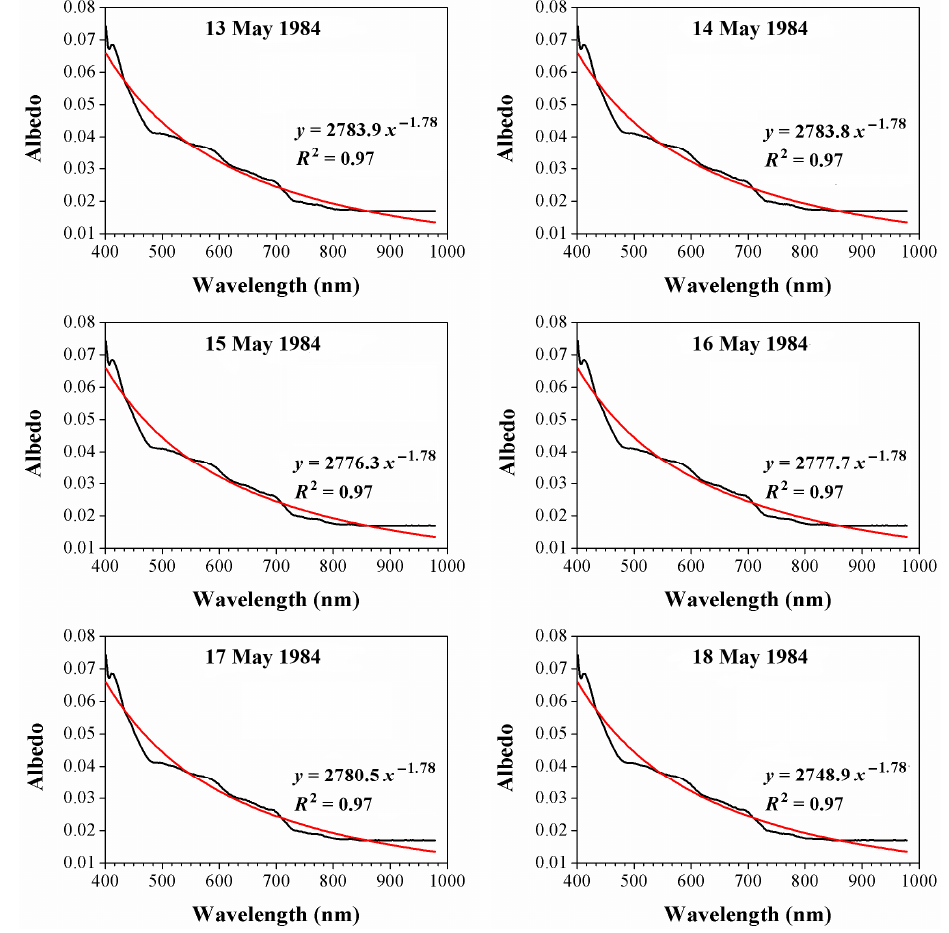
Figure 3. Spectral dependence of water albedo (above Lake Ladoga) in the visible and near-infrared spectra (neglecting UV), as deduced from airborne observations conducted on six consecutive days. Table 6. Dates and fit equations along with the errors of the coefficients for sand albedo shown in Fig. 6. All given a , b , and c values are statistically significant at the 95% confidence